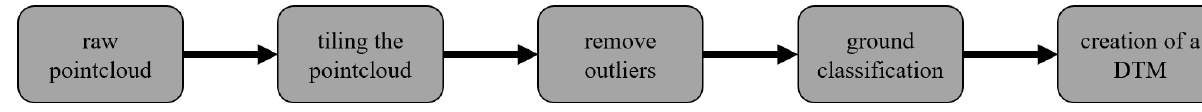
Figure 3: Workflow of the filtering and classification of the raw pointcloud data.